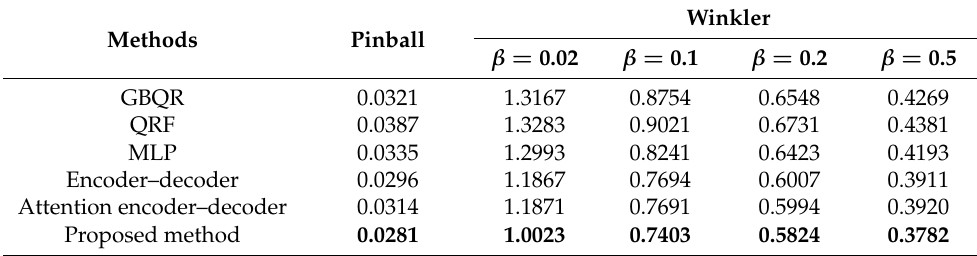
Table 2. Performance comparison of different methods for probabilistic